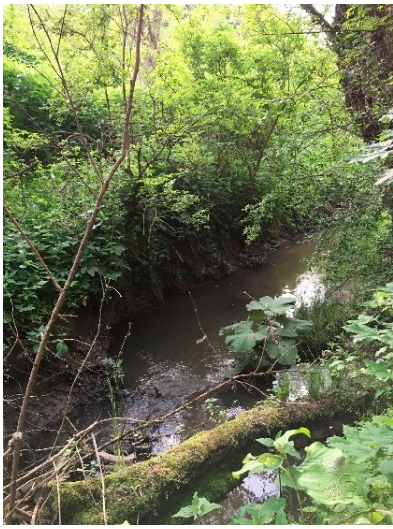
Figure 11. M ă lâncrav River refuge habitat. Figure 11. M ă l â ncrav River refuge habitat.